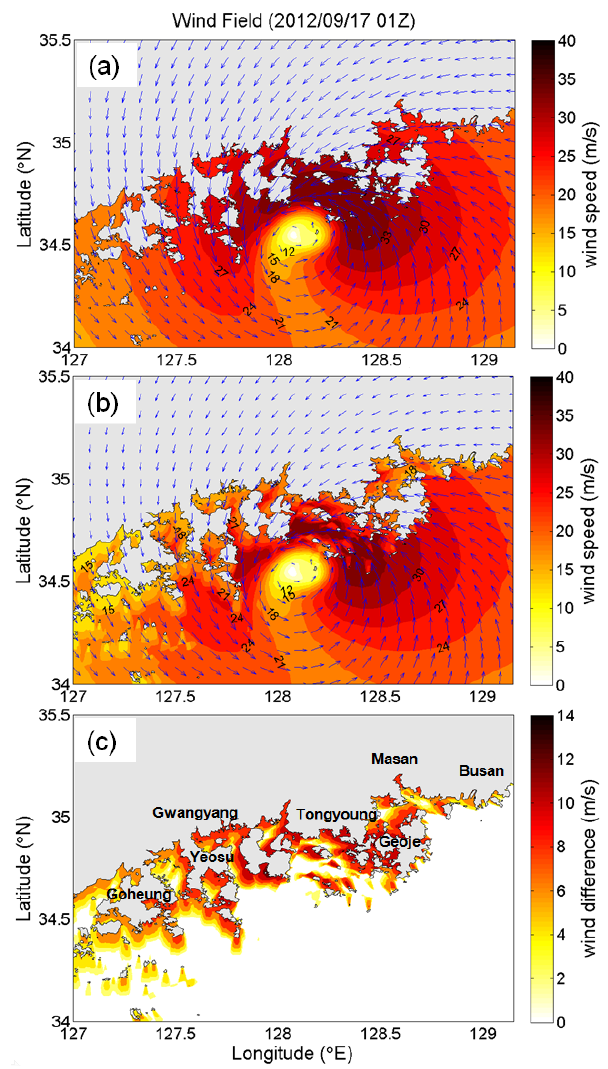
Figure 7. A comparison of simulated wind fields given the wind dissipation effect ( (a) excluding land dissipation; (b) including land dissipation; (c) the magnitude of the dissipated wind